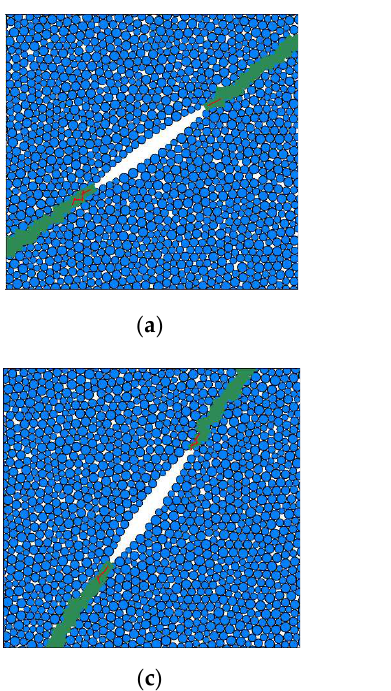
Table 2. Stress intensity factors of interface crack with different inclination angles.